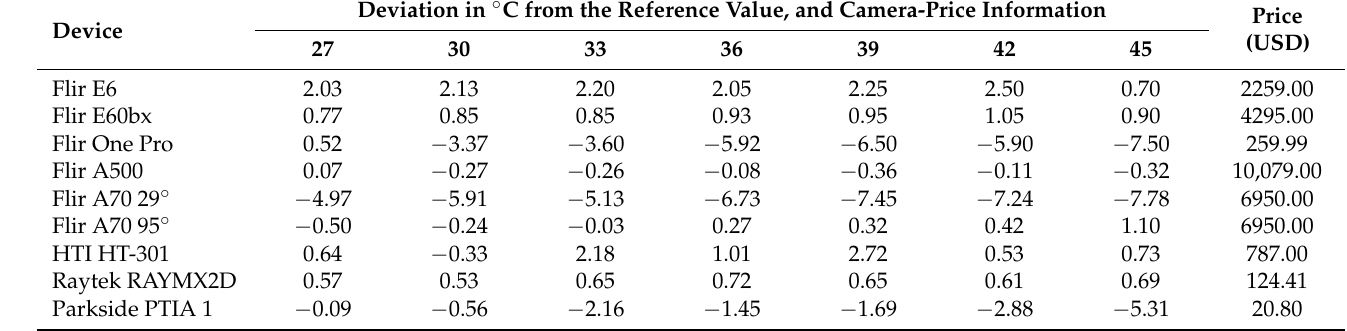
Table 6. Deviation in ◦ C from the reference value, and camera-price information.